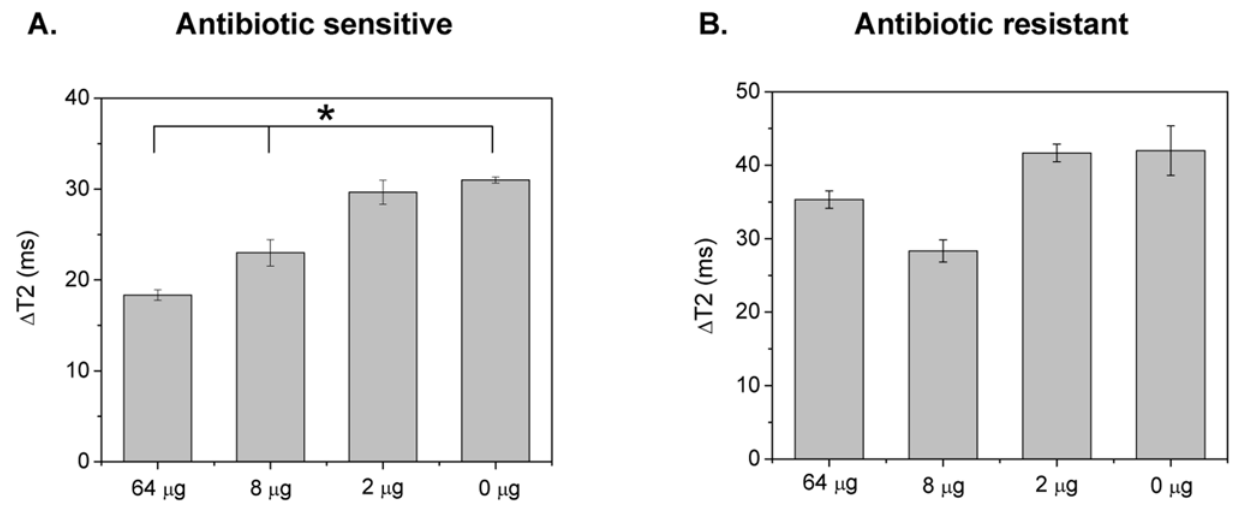
Figure 4. Dextran-coated polysaccharide nanosensor-mediated determination antimicrobial susceptibility in blood. (A) Assessment of E. coli ’s ampicillin MIC, and (B) identification of S. marcescens’ ampicillin resistance in blood (Means 6 SE; p , 0.05).